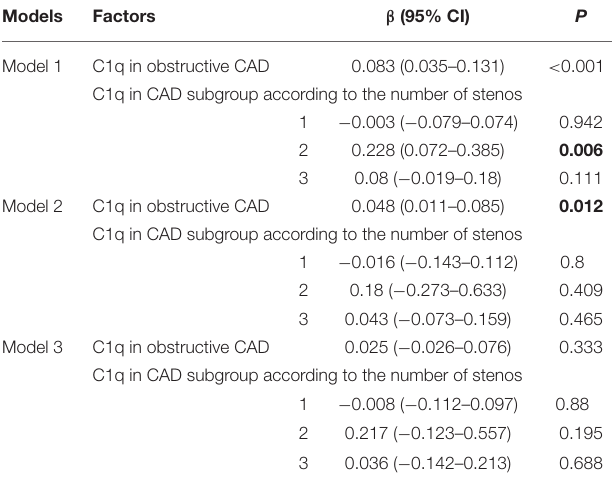
TABLE 3 | Linear regression analysis of Gensini score.